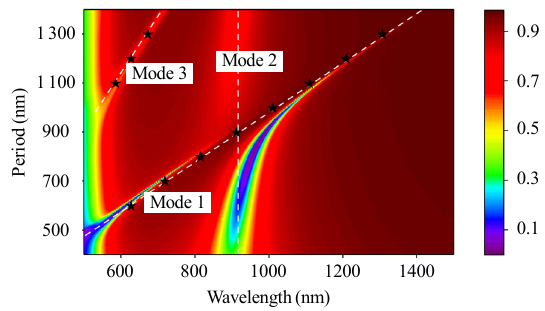
Fig. 2 Reflective spectra of the 1D grating composite structure. The period ranges from 400 nm to 1 400 nm and the colors represent the reflectivity distributions. The black stars show the resonance wavelengths calculated via the theoretical analysis under different periods.